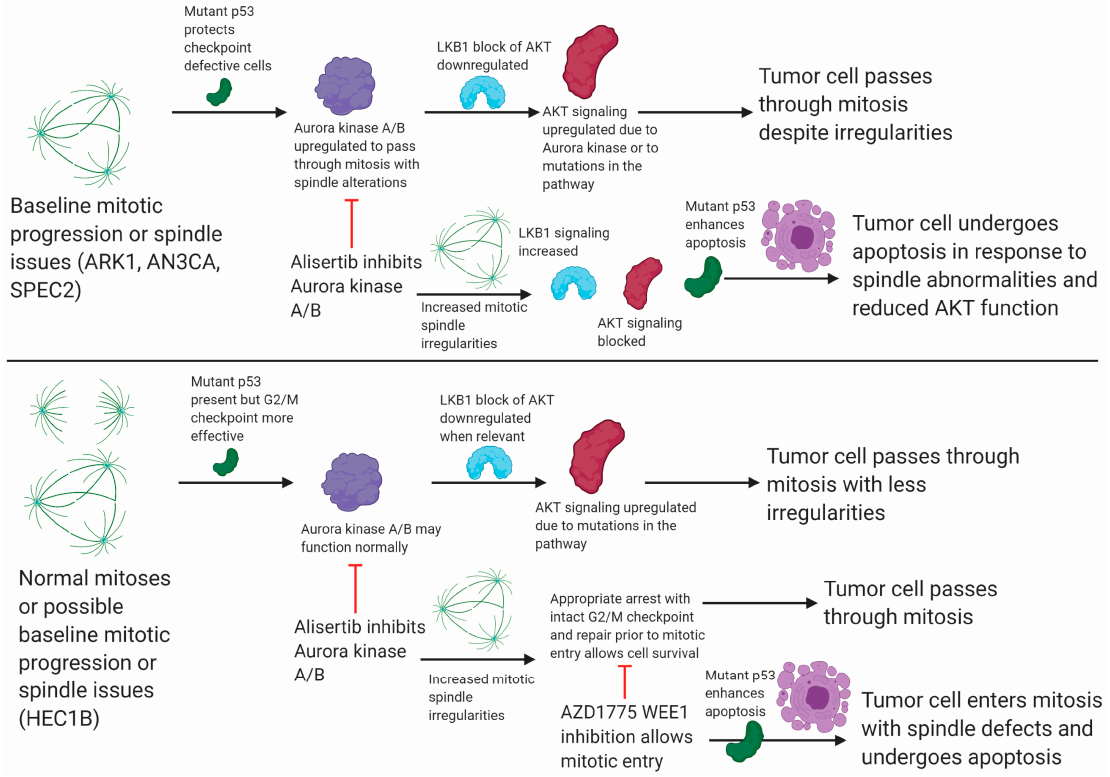
Figure 6. Aurora kinase signaling is an effective target in TP53 mutant uterine carcinomas with G2/M checkpoint dysfunction. Illustration of Alisertib effects on cells with or without functional G2/M checkpoints and how the addition of AZD1775 helps increase Alisertib